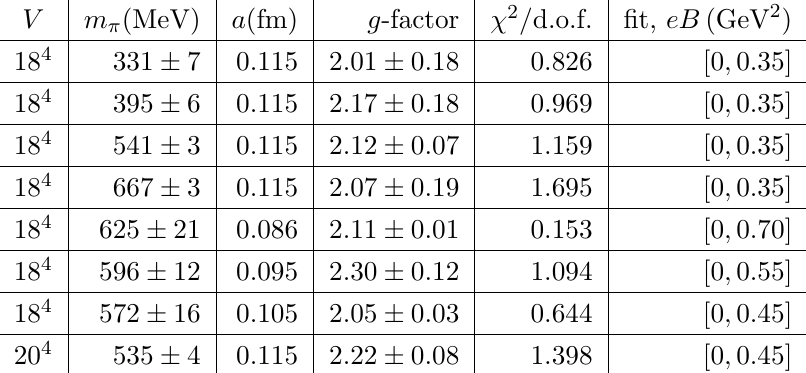
g -factor values are represented depending on the pion mass squared.